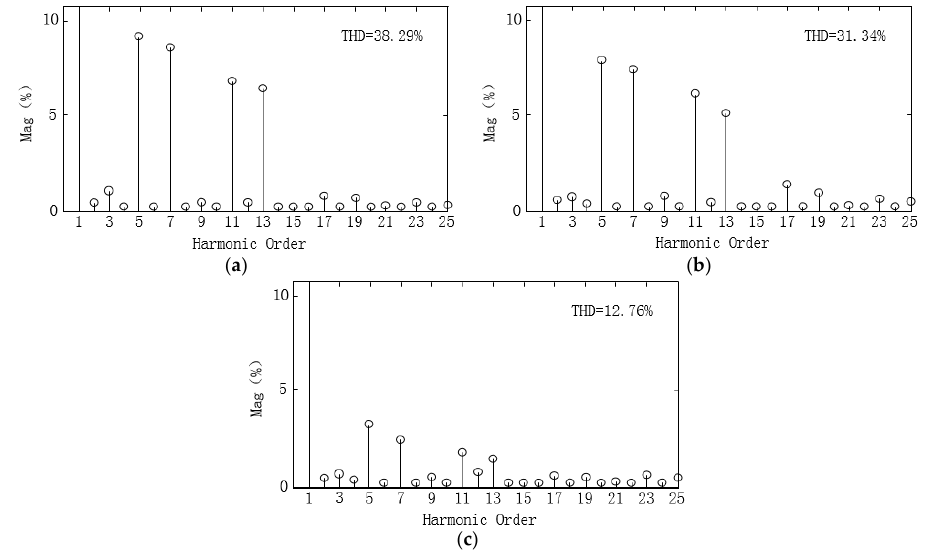
Figure 12. Simulation results of the stator current frequency spectrum of the PMSG with different impedance-source topologies. ( a ) With Z-source inverter; ( b ) With quasi-Z-source inverter; ( c ) With half quasi-Z-source inverter.